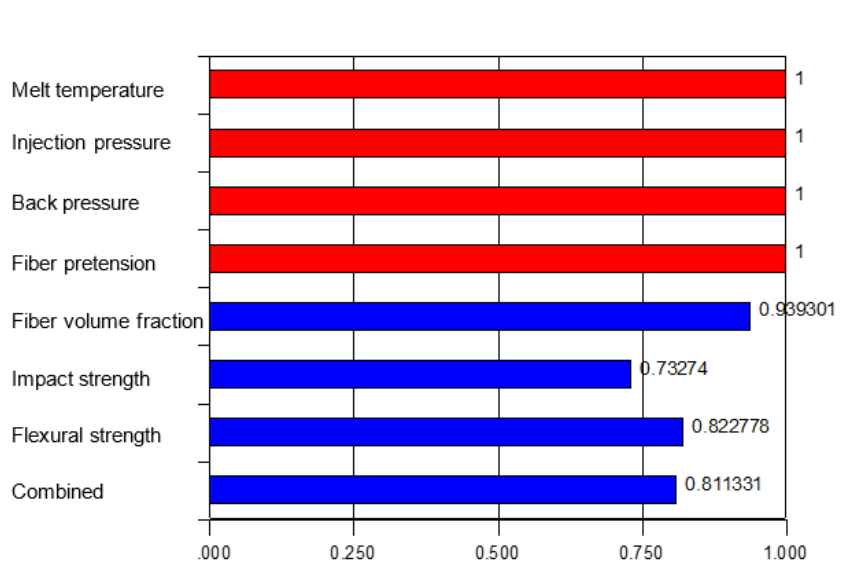
Figure 14. Desirability function.